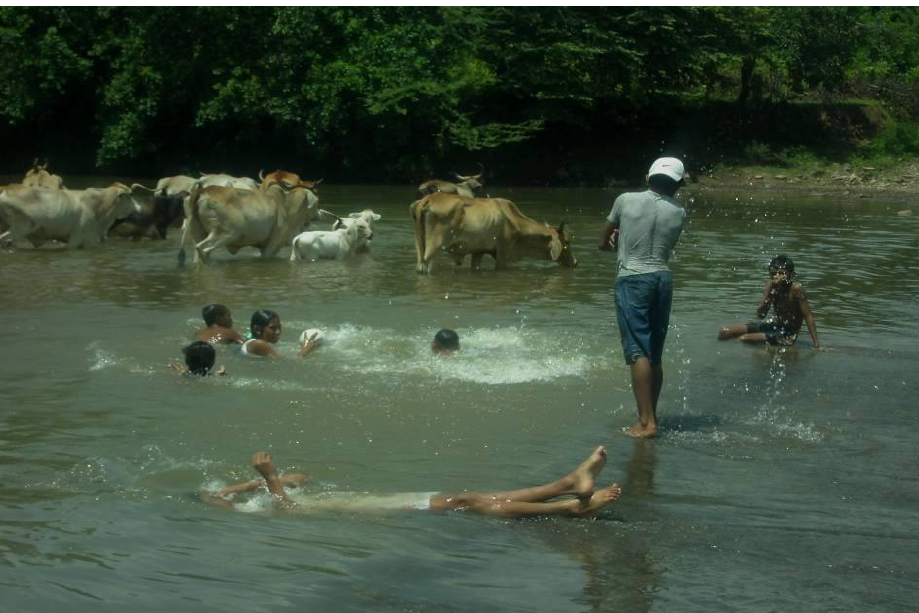
Figure 6. Humans and animals using the river in rural areas in